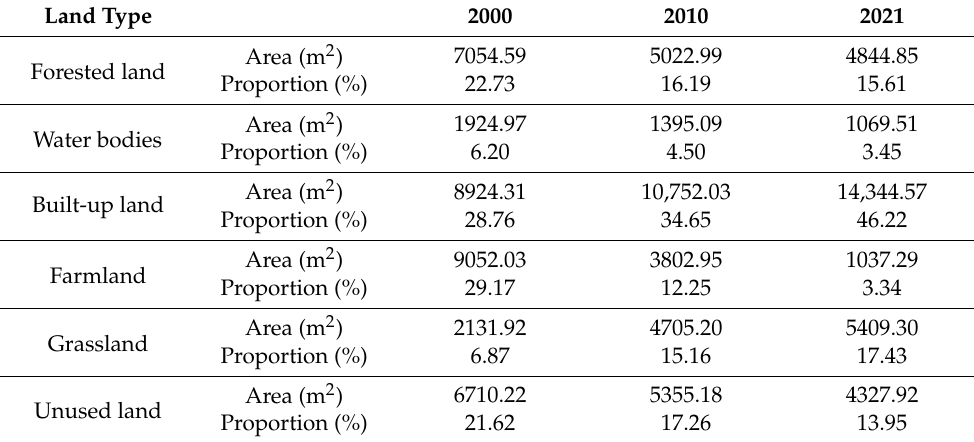
Table 4. Land use type structure in Fuzhou.